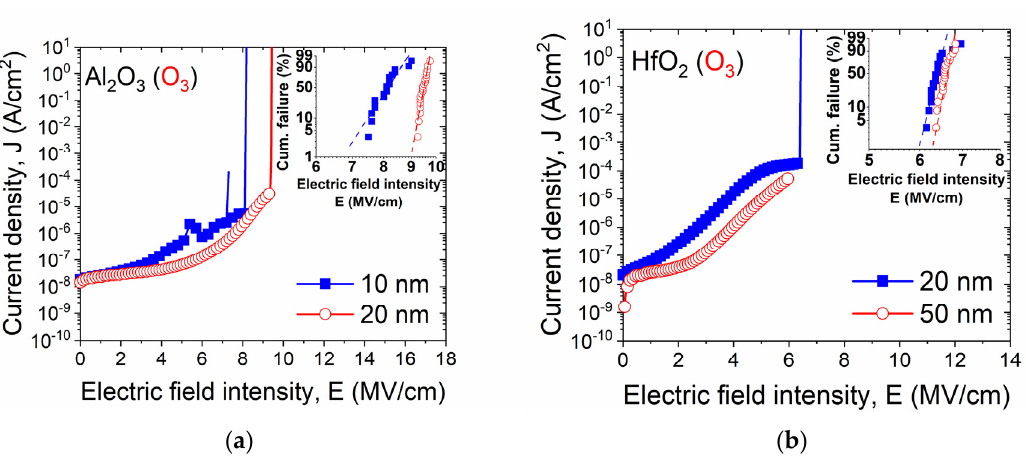
Figure 9. Comparison of representative I-V characteristics of MIS structures with ALD gate dielectric layers expressed as gate leakage current density vs. electric field intensity for ( a ) Al 2 O 3 and ( b ) HfO 2 ; Weibull plots of cumulative breakdown distribution vs. electric field intensity are also shown as